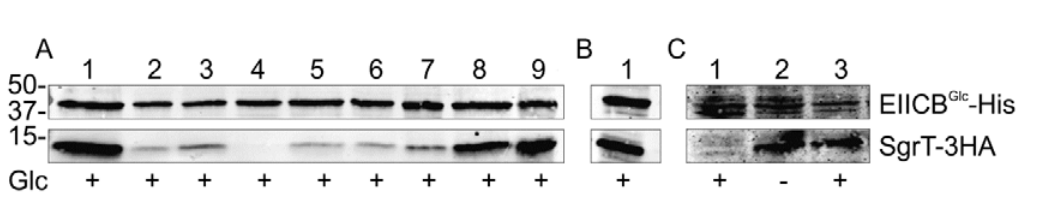
Figure 3. Crosslinking experiments with different KTPGRED mutants of EIICB Glc and